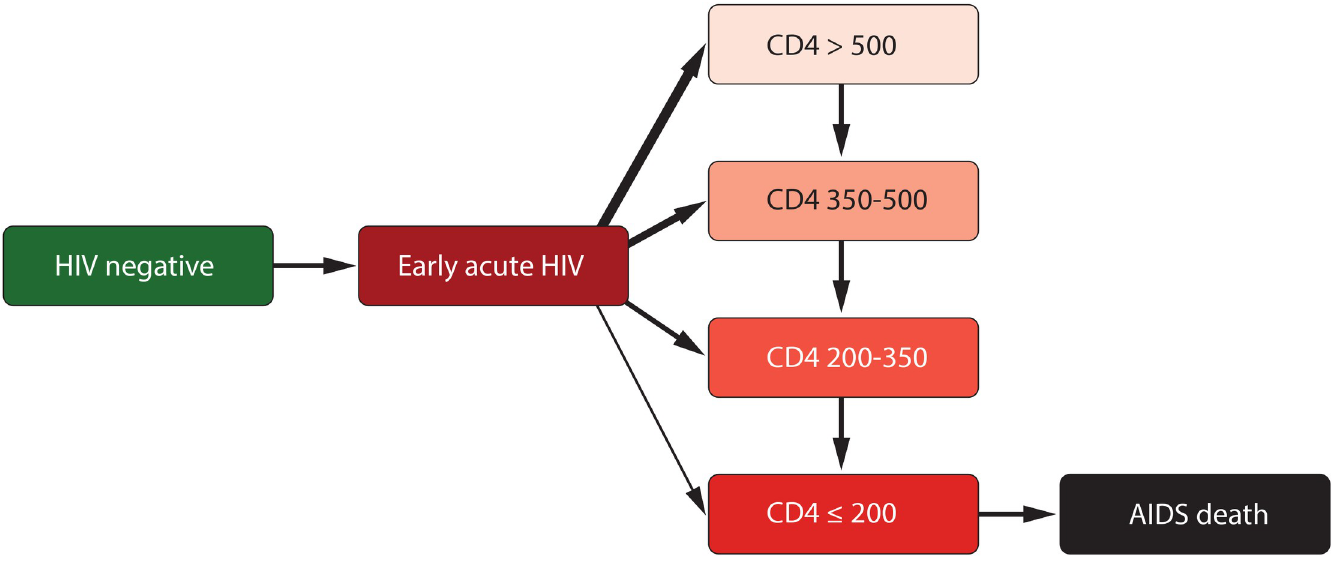
Fig 2. Schematic of HIV progression in the model in the absence of